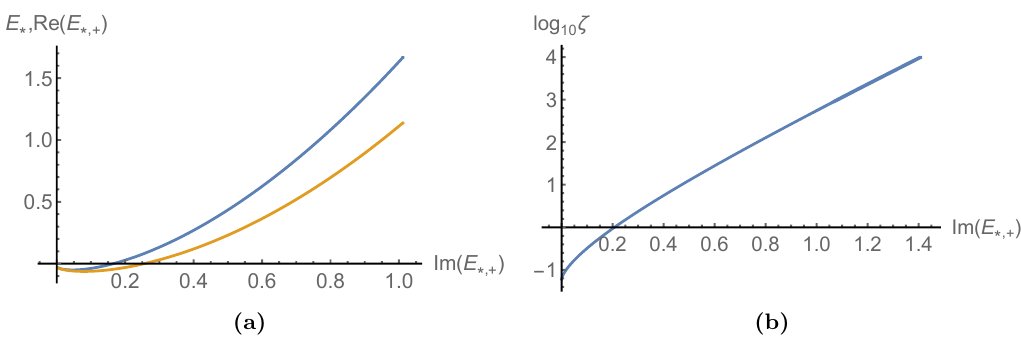
Figure 17. < ( E ∗ , + ) , E ∗ and log ζ as a function of = ( E ∗ , + ) . We set 2 φ b = 1 in both plots. 10 For t ∈ R , the metric has conical singularity at y = 0 unless W ( φ ) ∈ R and t have the h same periodicity as (5.9). The condition W ( φ ) ∈ R gives the allowed complex φ , which h h defines the support of the complex part of the spectrum γ via E ( φ ) (see figure 16b). The ∗ h endpoint of γ corresponds to W ( φ ) = 0 as it is the singularity of metric ∗ h